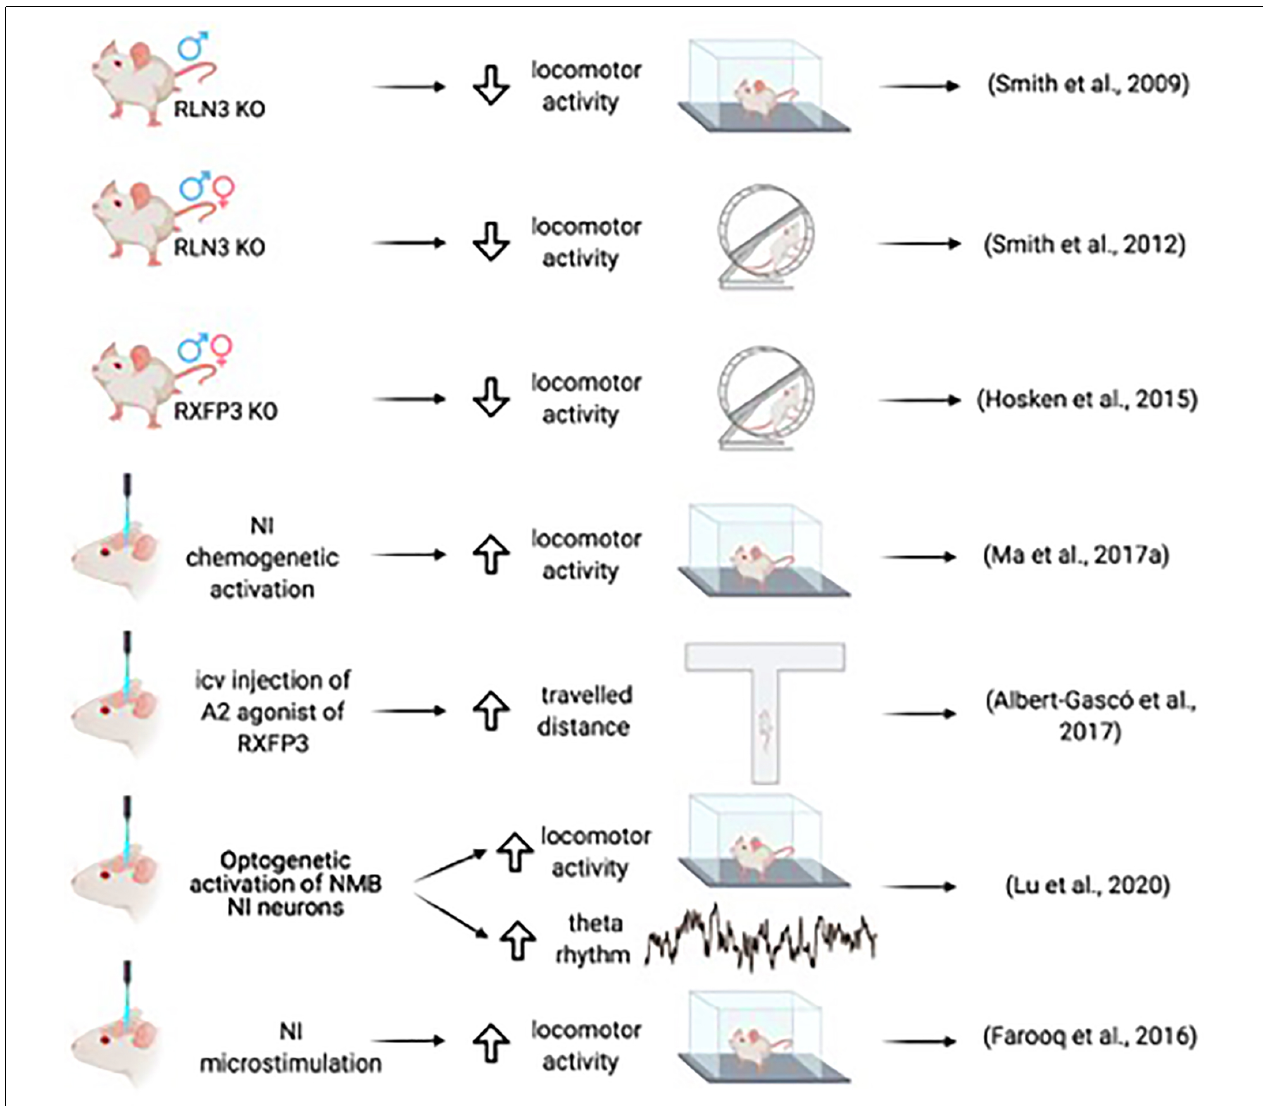
FIGURE 2 | Summary of the main effects of NI-RLN3-RXFP3 activation on locomotor